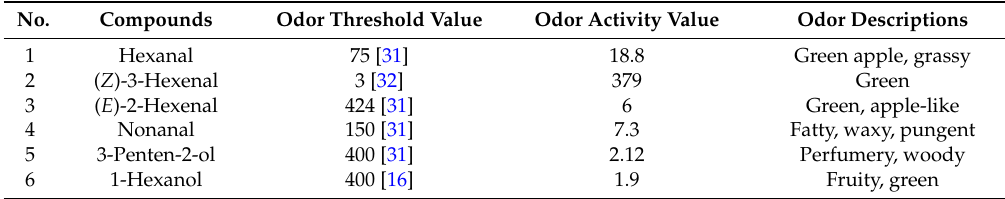
Table 3. Odor thresholds and odor activity values (OAVs) of potent volatile compounds in Ayvalik olive